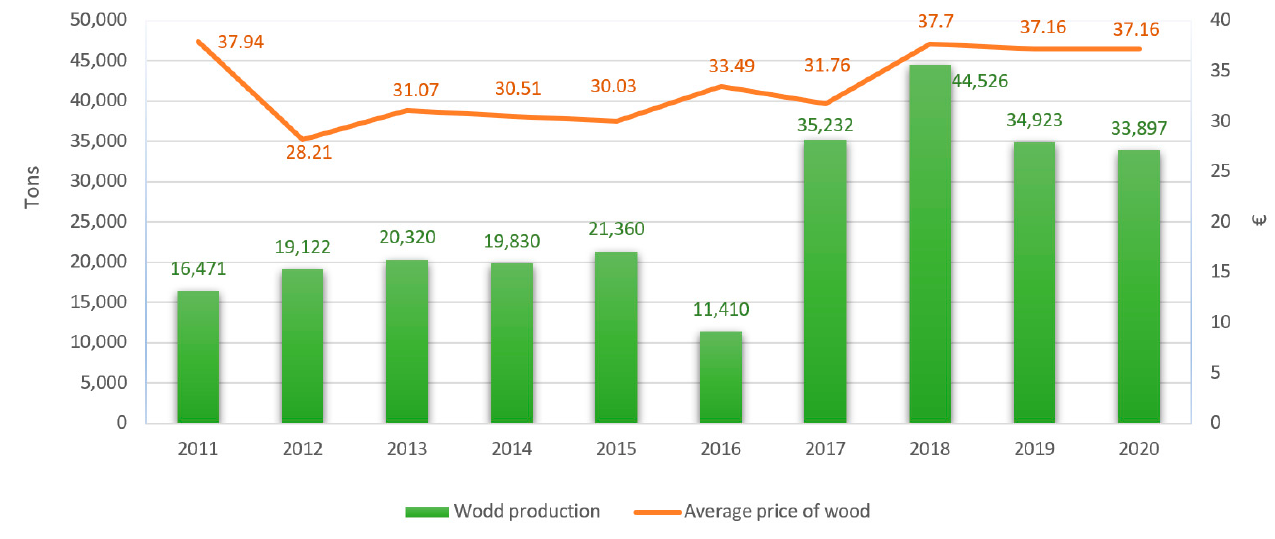
Figure 4. Wood production and average price per ton of wood marketed in Galicia